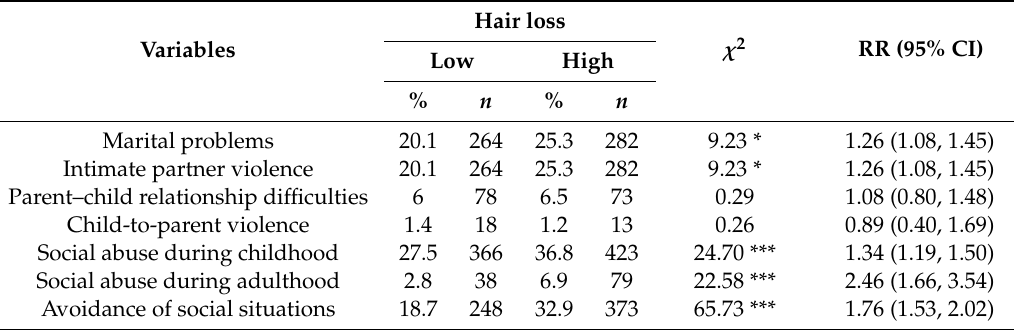
Table 3. Family and social